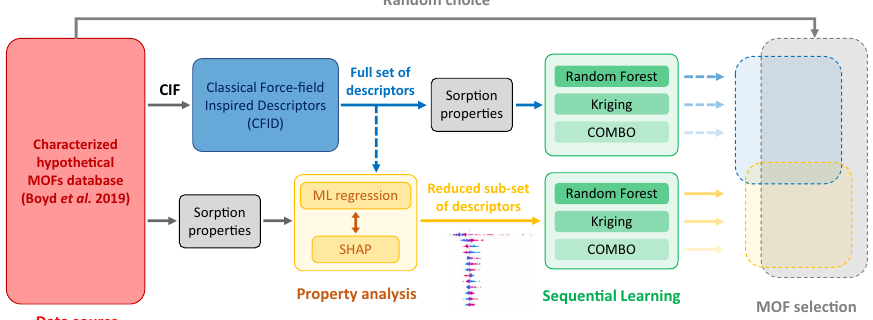
Fig. 1 Overview of the protocol to identify and test the minimal set of ruling crystallographic descriptors of sorption properties in several sequential learning algorithms. Over 5000 hypothetical MOFs from ref. 46 are fi rst featurized by CFID, with the corresponding full set of descriptors provided to a ML regression pipeline for a preliminary descriptor reduction and ML model training of sorption properties of interest. The Tree SHAP interpretation algorithm is thus used to fi nalize the identi fi cation and ranking of a reduced subset of ruling descriptors of the chosen property). Several sequential learning schemes are tested using both the full set of descriptors and the reduced one for a comprehensive